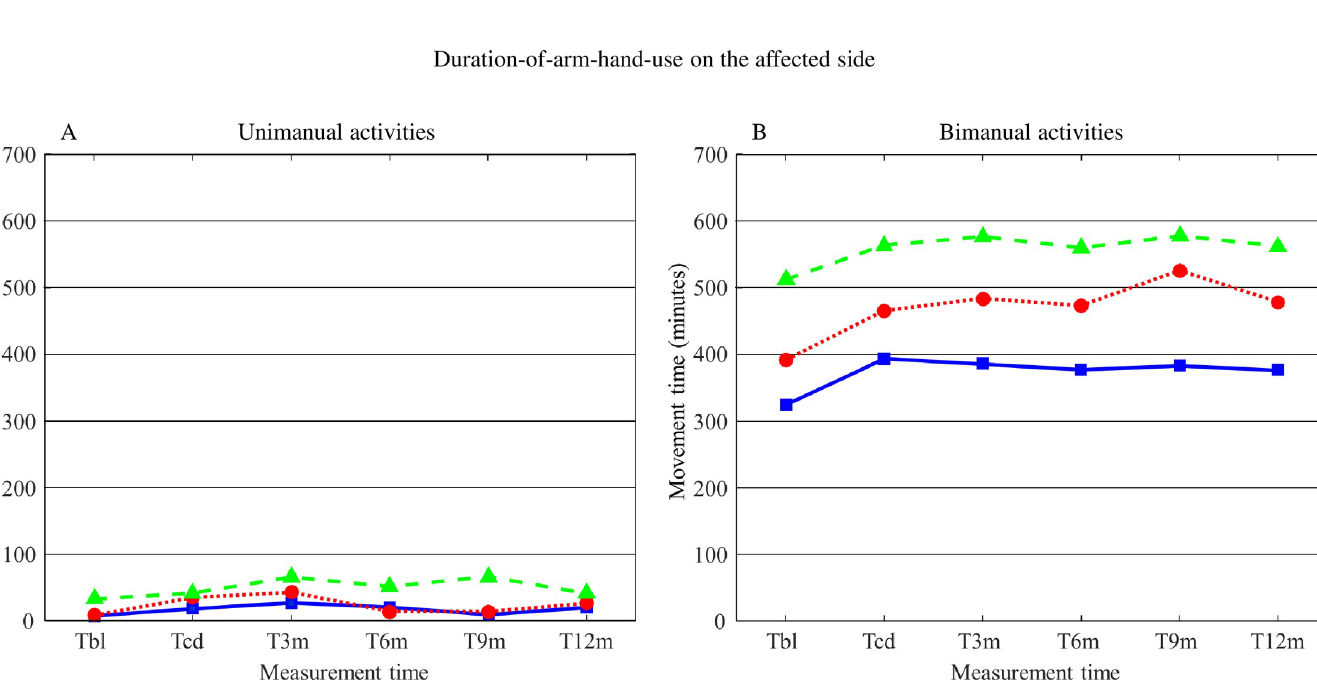
Fig 5. A: Mean values for Duration-of-arm-hand-use on the affected side during unimanual activities for subgroups 1, 2 and 3. B: Mean values for Duration-of- arm-hand-use on the affected side during bimanual activities for subgroups 1, 2 and 3. T = time; bl = baseline; cd = clinical discharge; m = month. Solid line = subgroup 1; Dotted line = subgroup 2; Dashed line = subgroup